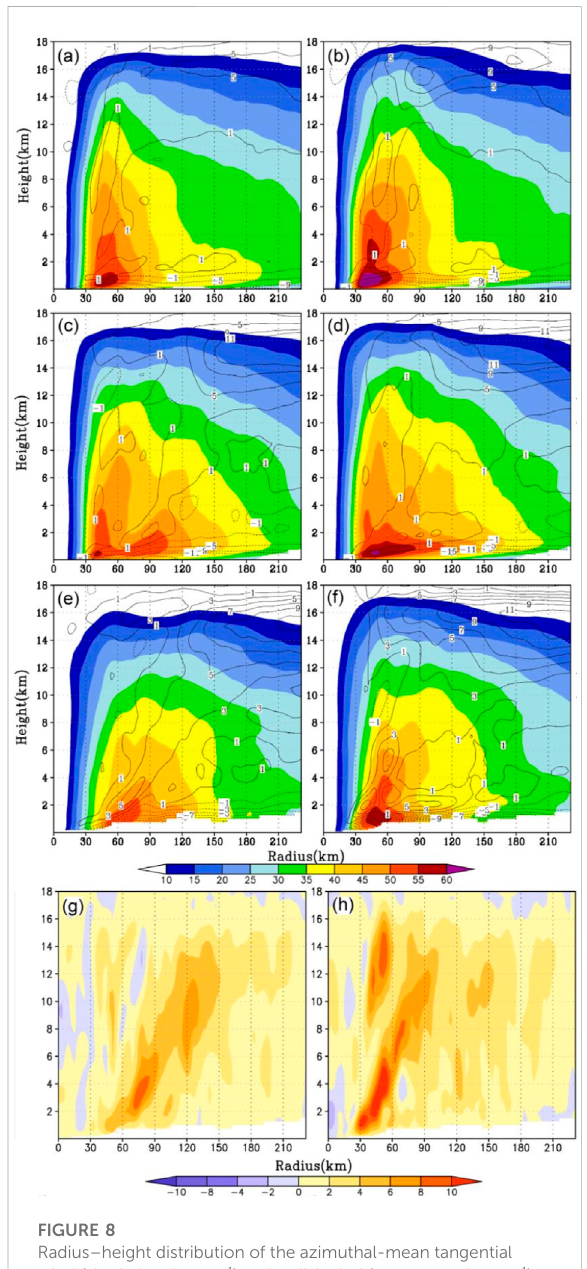
FIGURE 8 Radius – height distribution of the azimuthal-mean tangential wind (shaded, unit: m s − 1 ) and radial wind (contour, unit: m s − 1 ) at (A,B) 12:00 UTC on 8 August 2019, (C,D) 06:00 UTC on 9 August 2019, and (E,F) at the landing time in the (A,C,E) CTL and (B,D,F) PBL1 experiment. (G,H) as in (E,F) but for vertical velocity (shaded, unit: 10 – 1 m s − 1